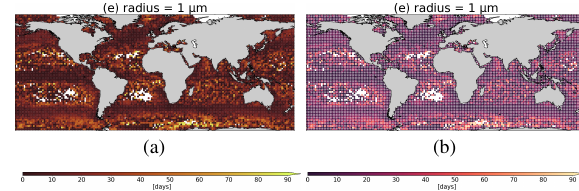
Figure 8. Counter-acting the dark base-tone of the plot for overall short sinking timescales by (a) shrinking the lower-end scale of the colour map or (b) plotting a gridded scatterplot with circular glyphs.